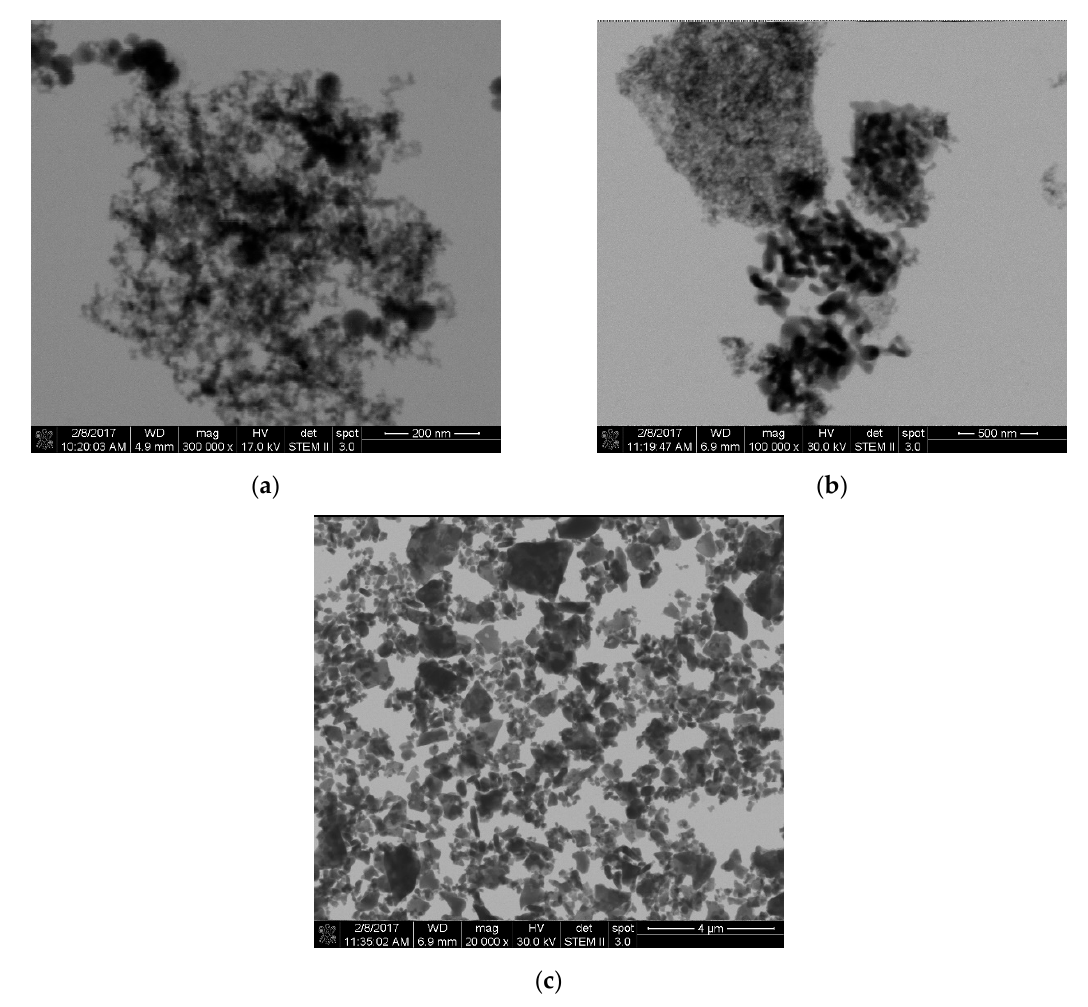
Figure 3. HRSEM images of as-received 13 nm ( a ), 35 nm ( b ) and 100 nm ( c ) sized alumina.